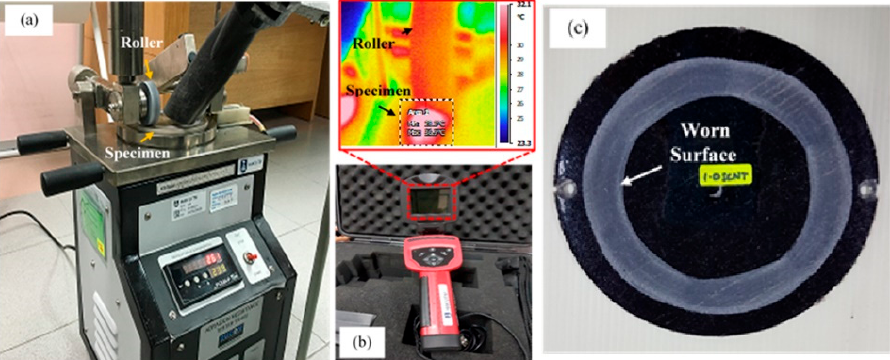
Figure 1. ( a ) The experiment set-up for the abrasion wear test, ( b ) infrared thermal image camera, and ( c ) composite specimen (diameter: 123 mm, thickness: 5 mm) after wear test.